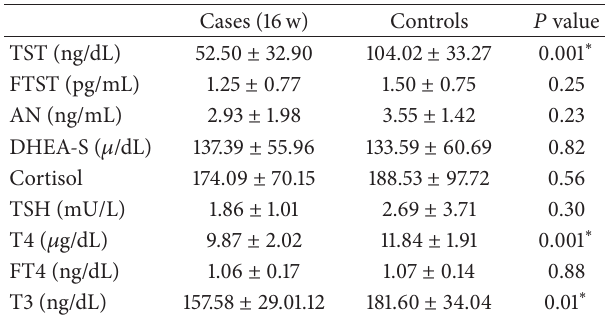
Table 4: Cases versus controls 2 weeks after HM evacuation. Cases